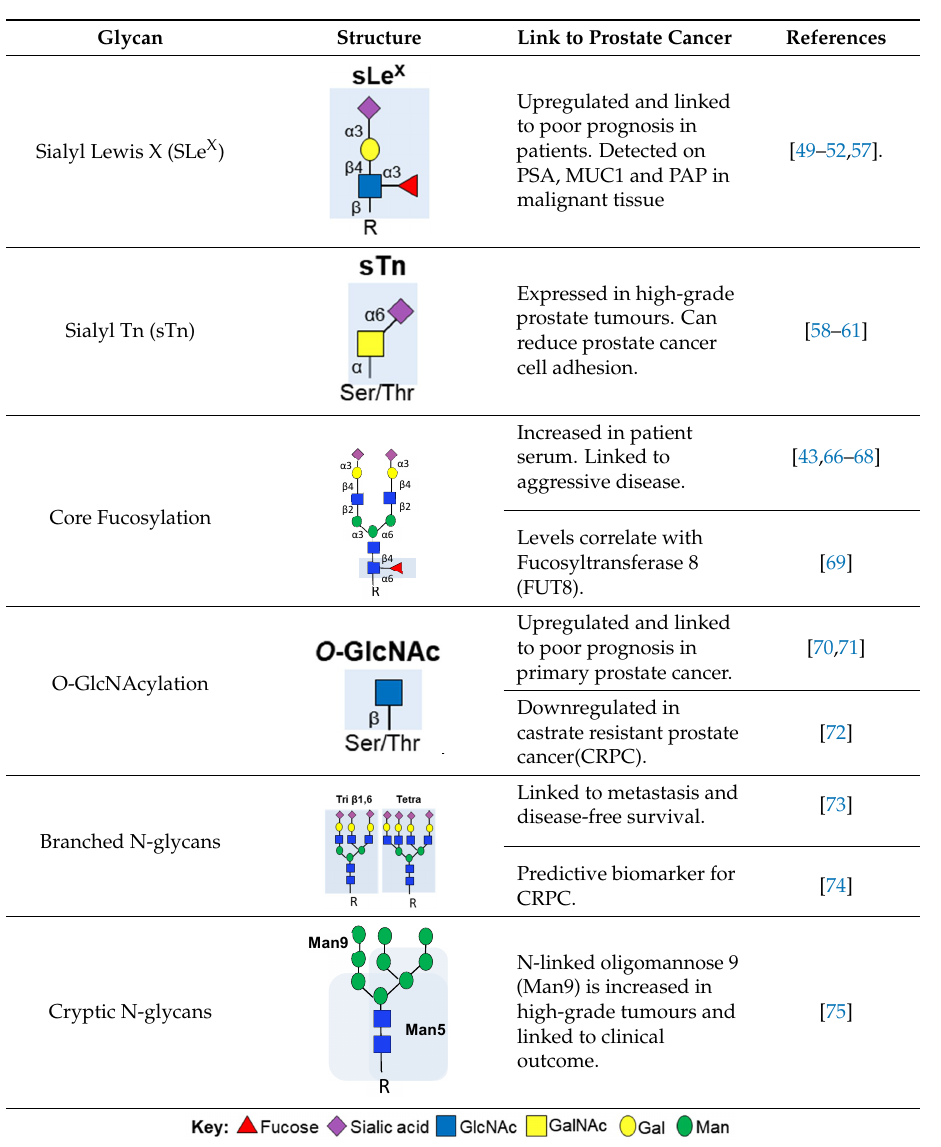
high-grade tumours and linked to clinical outcome.